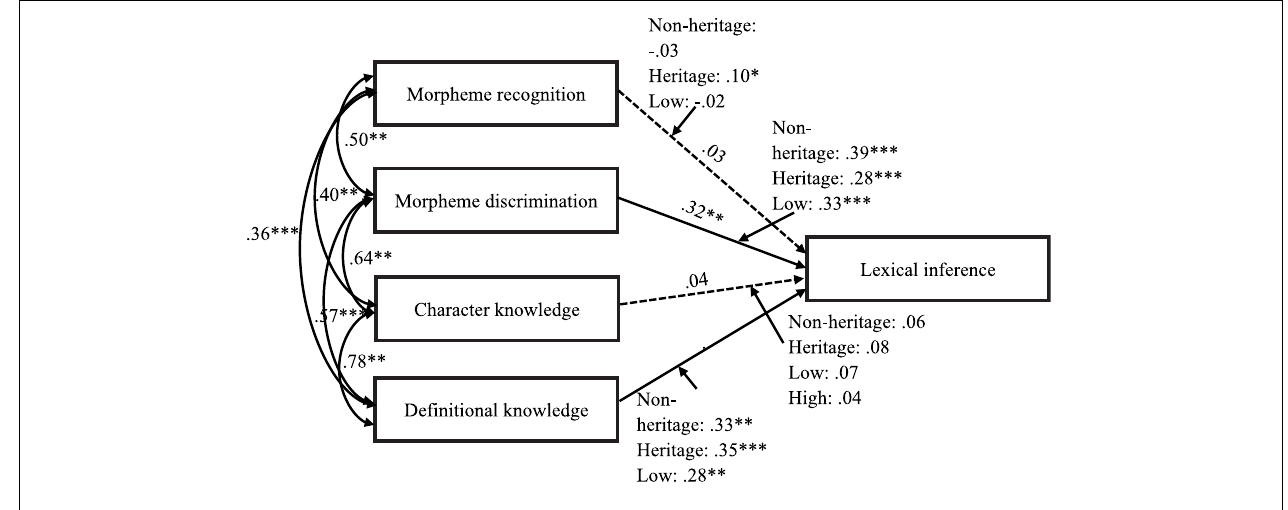
FIGURE 2 | Path diagram of the moderation effect. ∗ p < 0.05, ∗∗ p < 0.01, ∗∗∗ p <